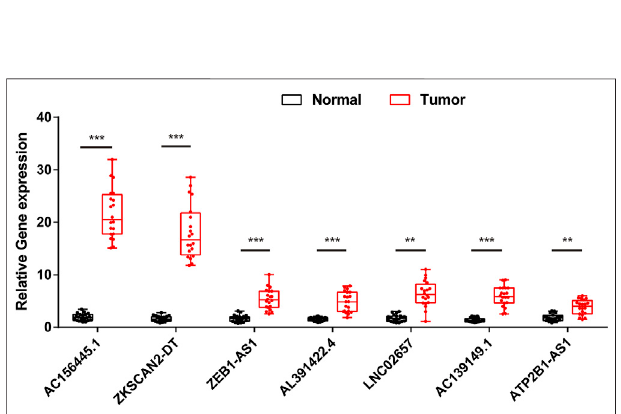
FIGURE 14 | The expression levels of seven m6A-related lncRNAs in 20 paired COAD and matched adjacent normal tissues were examined by